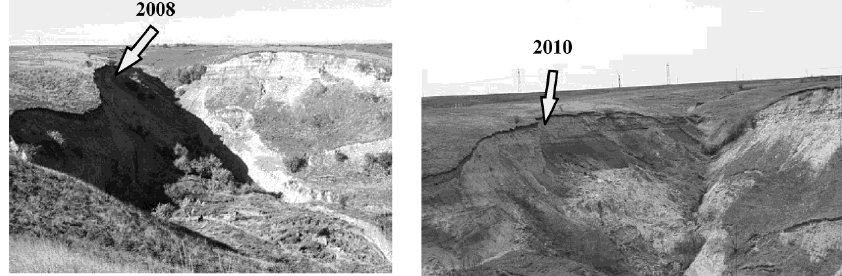
Fig. 24. The slope recession at the top of the secondary gully – between 2008 and 2010.